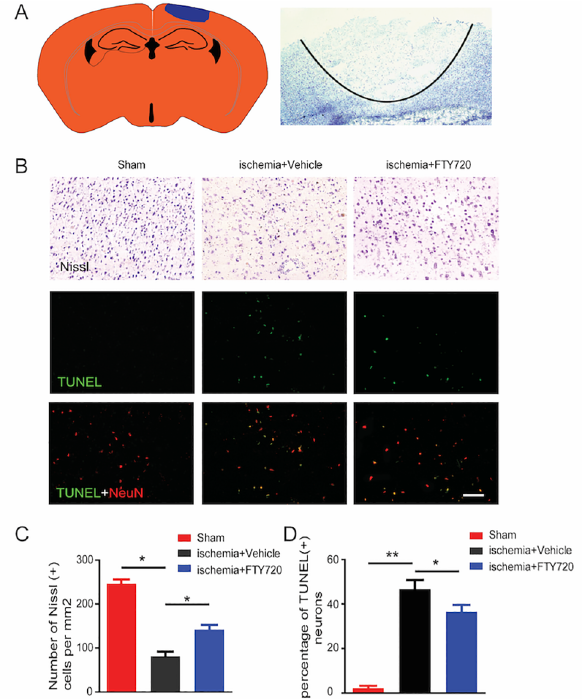
Fig 2. FTY720 attenuates neuronal apoptosis following ischemic stroke. A, Schematic diagramof the photothrombotic stroke model (left) and ischemic lesionsevaluatedby Nissl staining(right). B, Nissl staining (B1-3) and TUNEL assays (B4-9) were performed to assess effects of FTY720 on neuronalsurvival and apoptosisin the boundary of the ischemiclesion core at 1 day post injury. Sham mice (without ischemia induction) were also tested in parallel.The scale bar represents50 μ m. C, Quantification of the results from panelsB1-3. D, Quantification of the results from panelsB4-6. (n = 4 for each group, #p < 0.05 vs. sham group, * p < 0.05 vs. ischemia+vehiclegroup, ** p < 0.01 vs. ischemia+vehicle group, one-wayANOVA followedwith Tukey post hoc